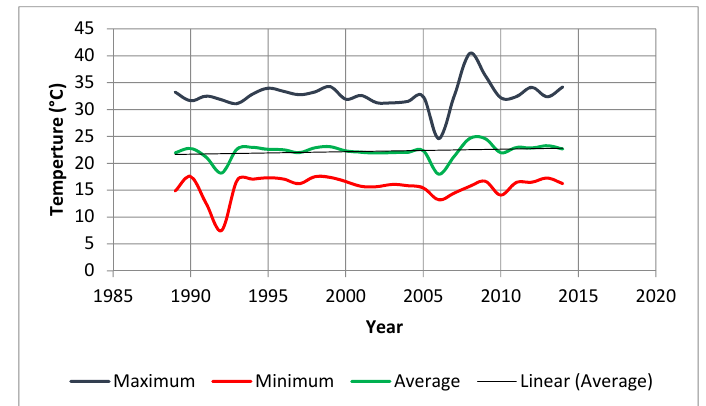
Figure 6. Temperature trend of Sindhuli Gadhi station.